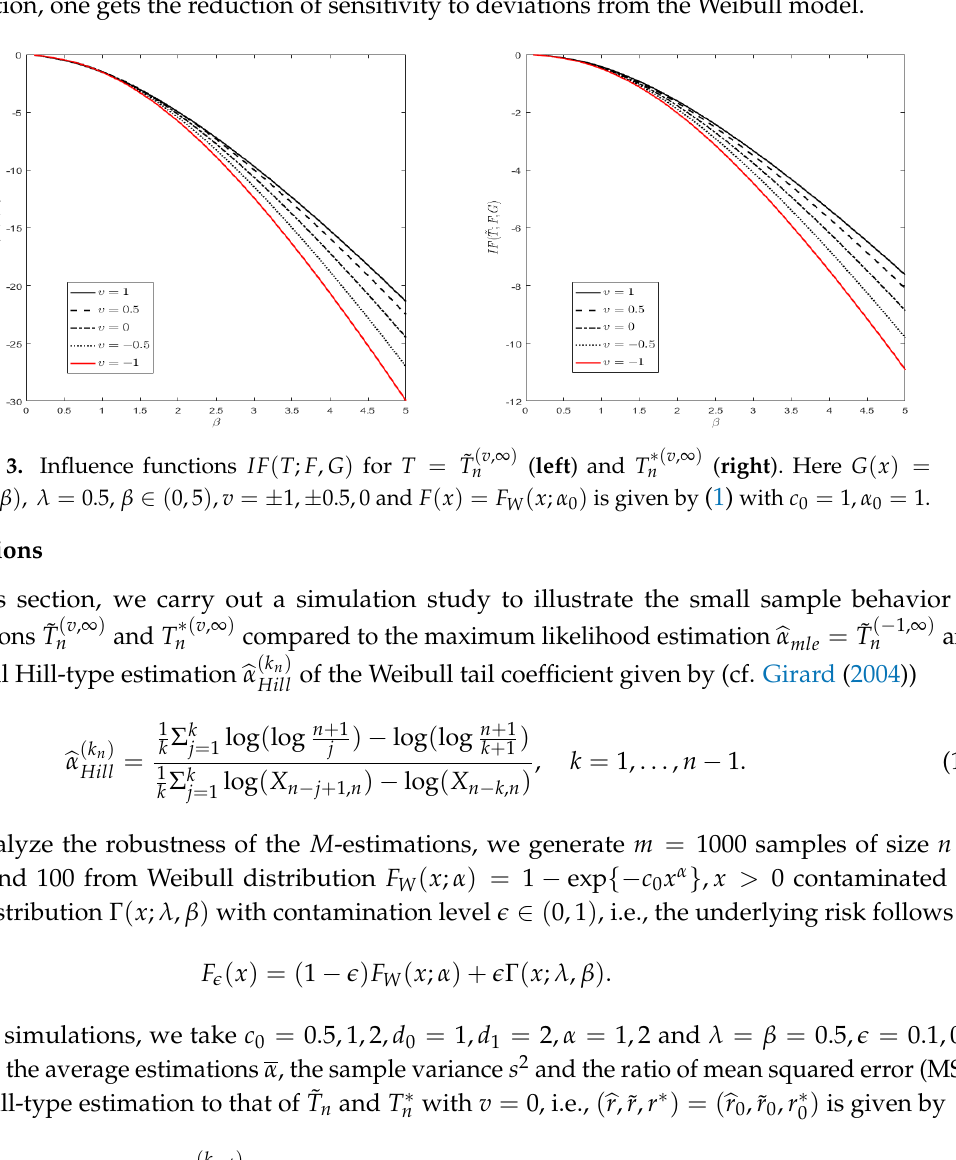
Figure 3. Influence functions IF ( T ; F , G ) for T = ˜ T Γ ( x ; λ , β ) , λ = 0.5, β ∈ ( 0,5 ) , v = ± 1, ± 0.5,0 and F ( x ) = F